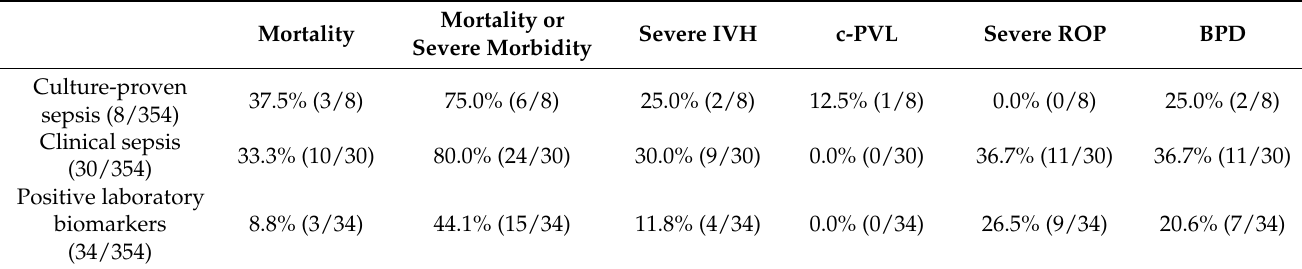
Table 3. Mortality, mortality or severe morbidity and the severe morbidities in detail in relation to the three different definitions of neonatal sepsis.